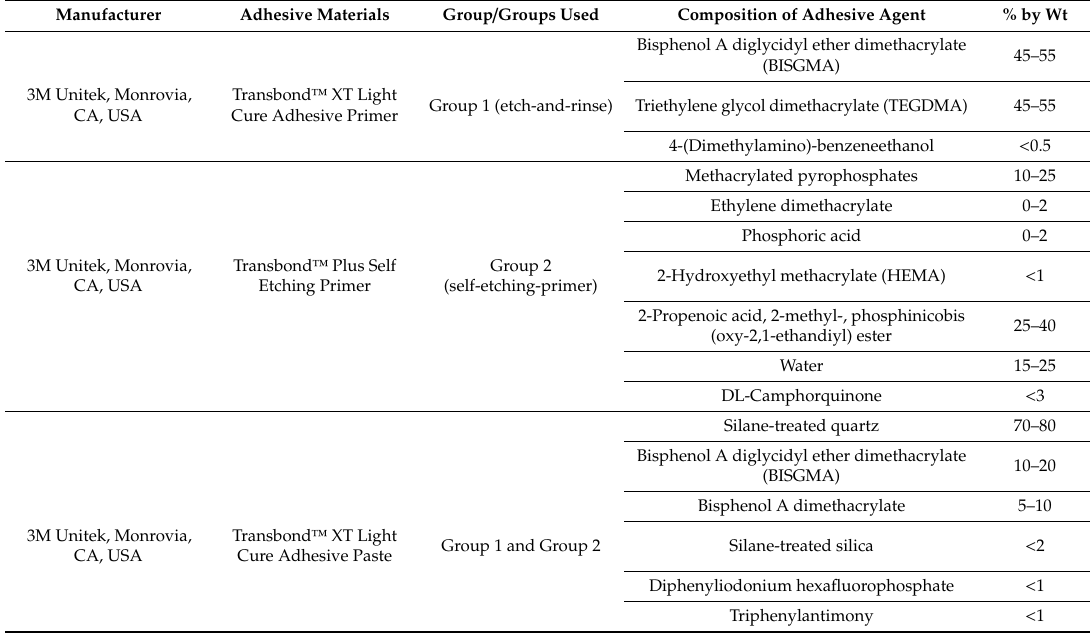
Table 1. Description and composition of adhesive agents used in the